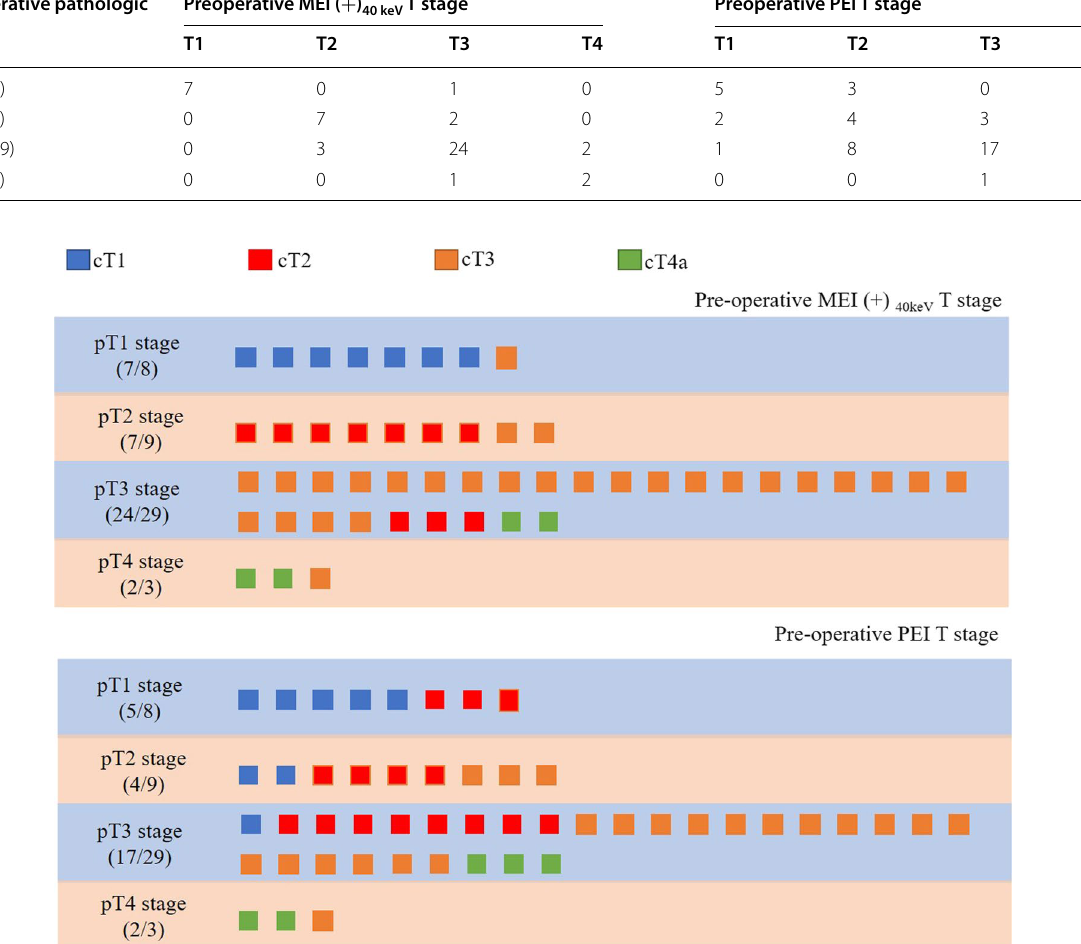
Fig. 4 Agreement between MEI ( ) 40 keV (or PEI) and pathologic T categories. Agreement between MEI ( + was 81.63% (40/49). Agreement between PEI and pathologic T categories was 48.97%